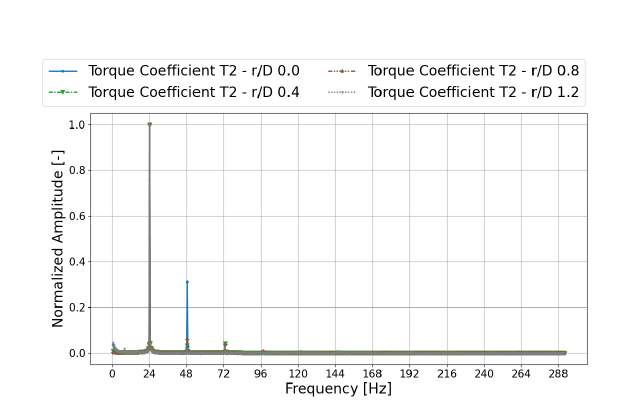
Fig. 11. Fast Fourier Transformation of torque coefficient of second turbine for every second simulation. Blade passing frequency of 24 . 4 Hz.